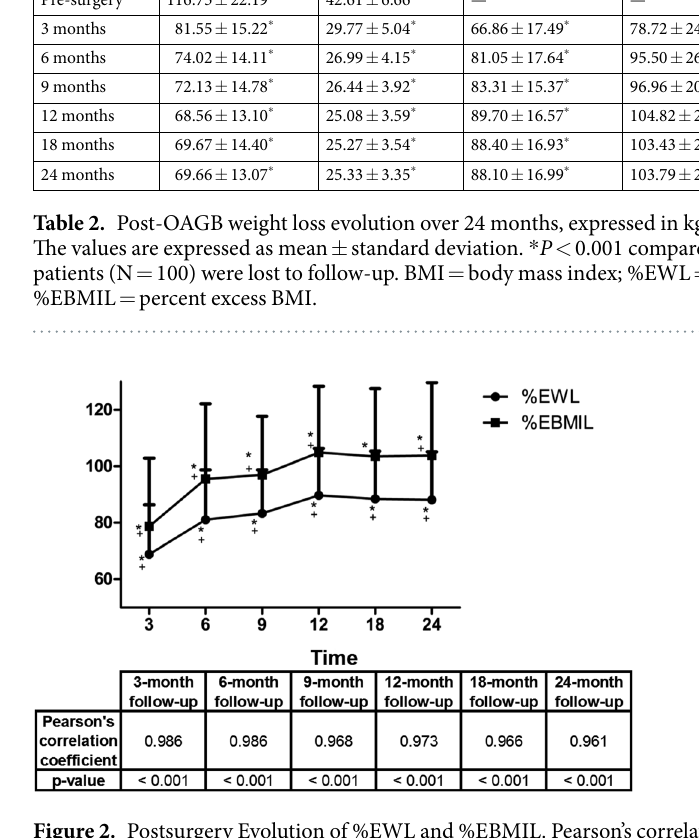
Figure 2. Postsurgery Evolution of %EWL and %EBMIL. Pearson’s correlation coefficient between %EWL and %EBMIL %EWL = percent excess weight loss; %EBMIL = percent excess body mass index. * P < 0.001 compared with the pre-surgery control. + P < 0.001 compared with the previous control. No patients were lost to